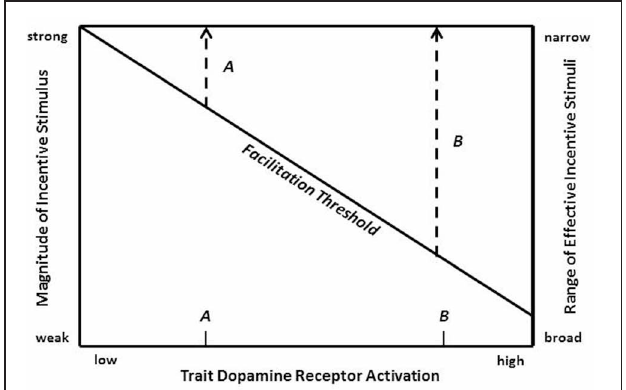
FIGURE 7 | A minimum threshold for facilitation of feelings of reward and extraverted behavior is illustrated as a trade-off function between incentive stimulus magnitude (left vertical axis) and dopamine (DA) postsynaptic receptor activation (horizontal axis). Range of effective (facilitating) incentive stimuli is illustrated on the right vertical axis as a function of level of DA activation. Two hypothetical individuals with low and high trait DA postsynaptic receptor activation (demarcated on the horizontal axis as A and B, respectively) are shown to have narrow (A) and broad (B) ranges of effective incentive stimuli,